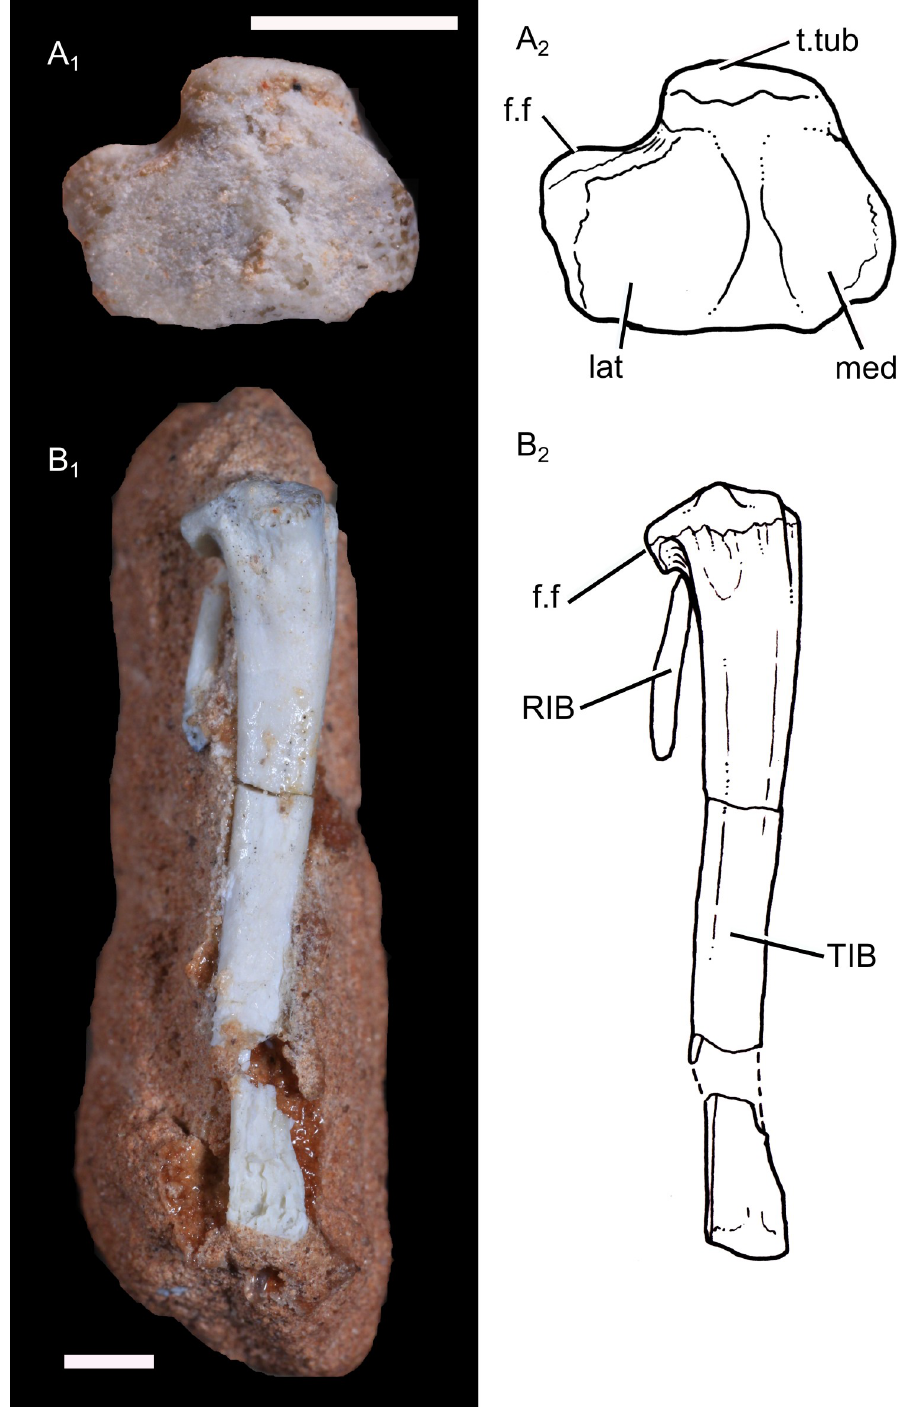
Fig 7. Photography (1) and drawing (2) of the left tibia of Brasilodon quadrangularis (UFRGS-PV-1043-T). A , in proximal view; B , in posteromedial view. Abbreviations: f.f , facet for the fibula; lat , facet for the lateral femoral condyle; med , facet for the medial femoral condyle; RIB , fragment of rib; TIB , tibia; t.tub , tibial tuberosity. Scale bar = 2 mm.